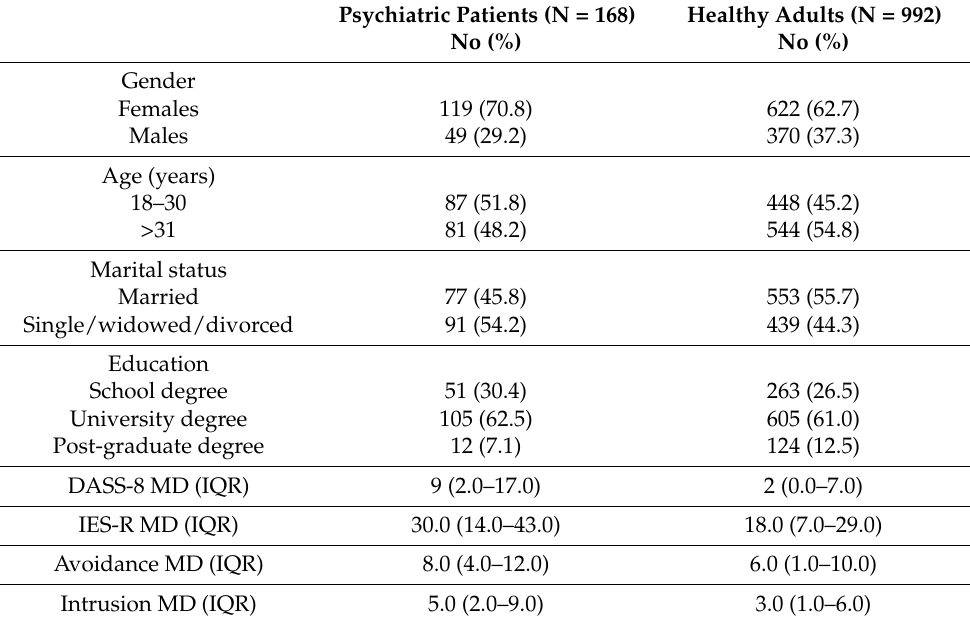
Table 1. Sociodemographic characteristics of the participants from the included